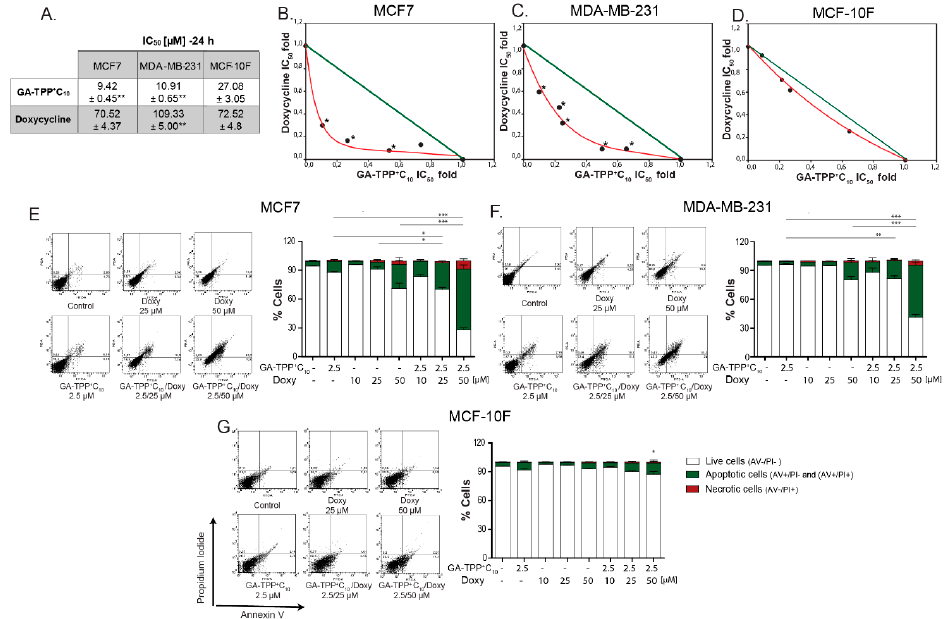
Figure 8. The GA-TPP + C 10 and Doxy combination triggers a synergistic cytotoxic effect. ( A – D ) Analysis of the effect of the pharmacological interaction triggered by the GA-TPP + C 10 plus Doxy combination on cell death in the BC and normal cells, ( E – G ) Quantification of the cell death induced by the GA-TPP + C 10 and Doxy combination at 24 h of exposure. * p < 0.05, ** p < 0.01, *** p < 0.001 vs. the control